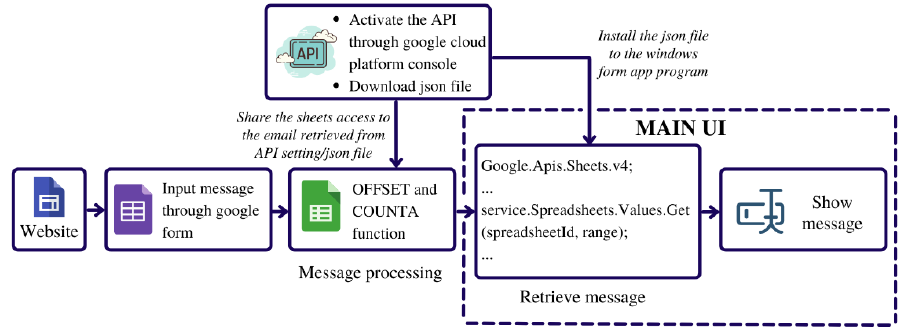
Figure 8. Working process of the messaging feature.